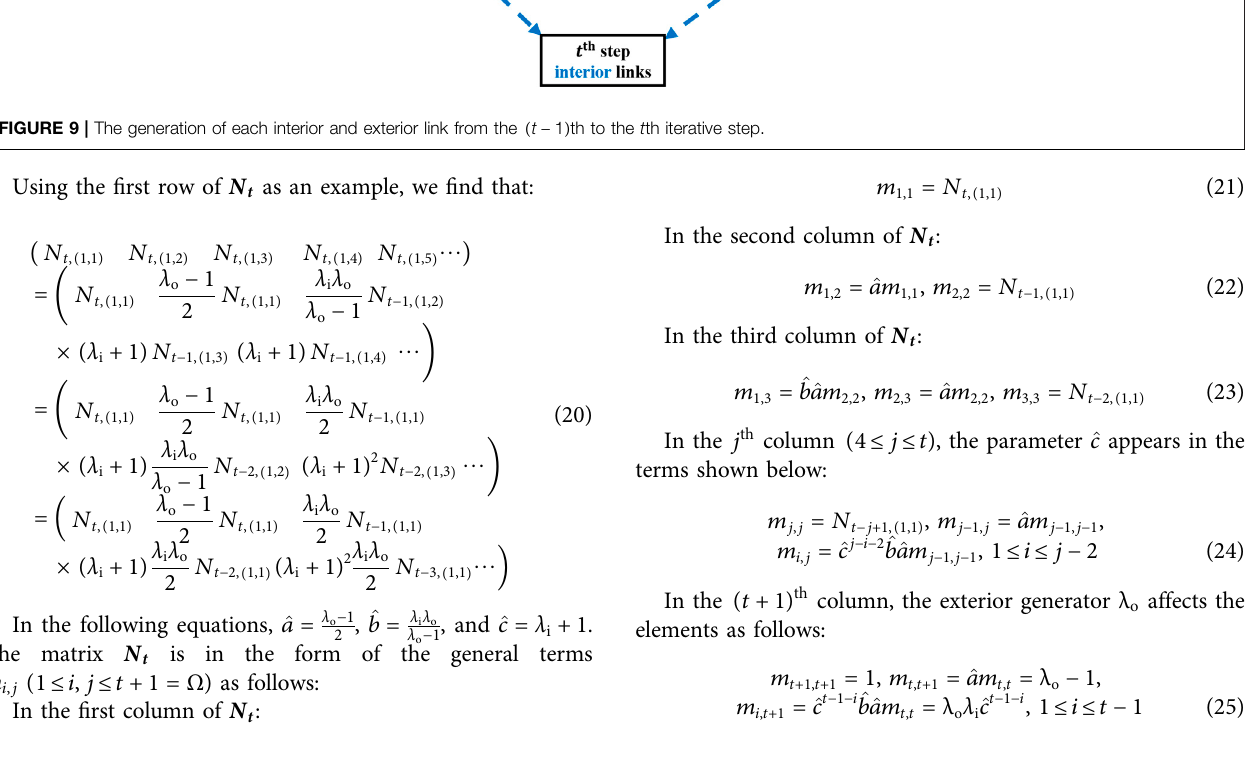
Frontiers in Environmental Science |